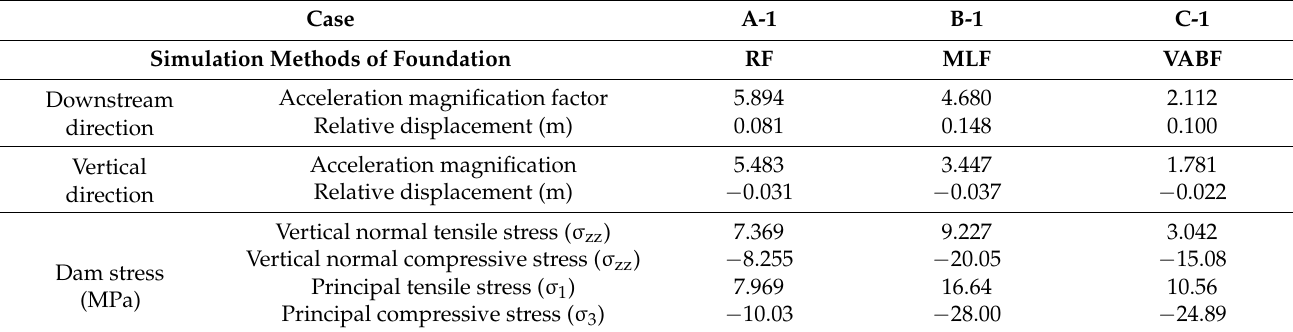
Table 3. The extreme values of dam dynamic response for different foundation simulation methods. Case A-1